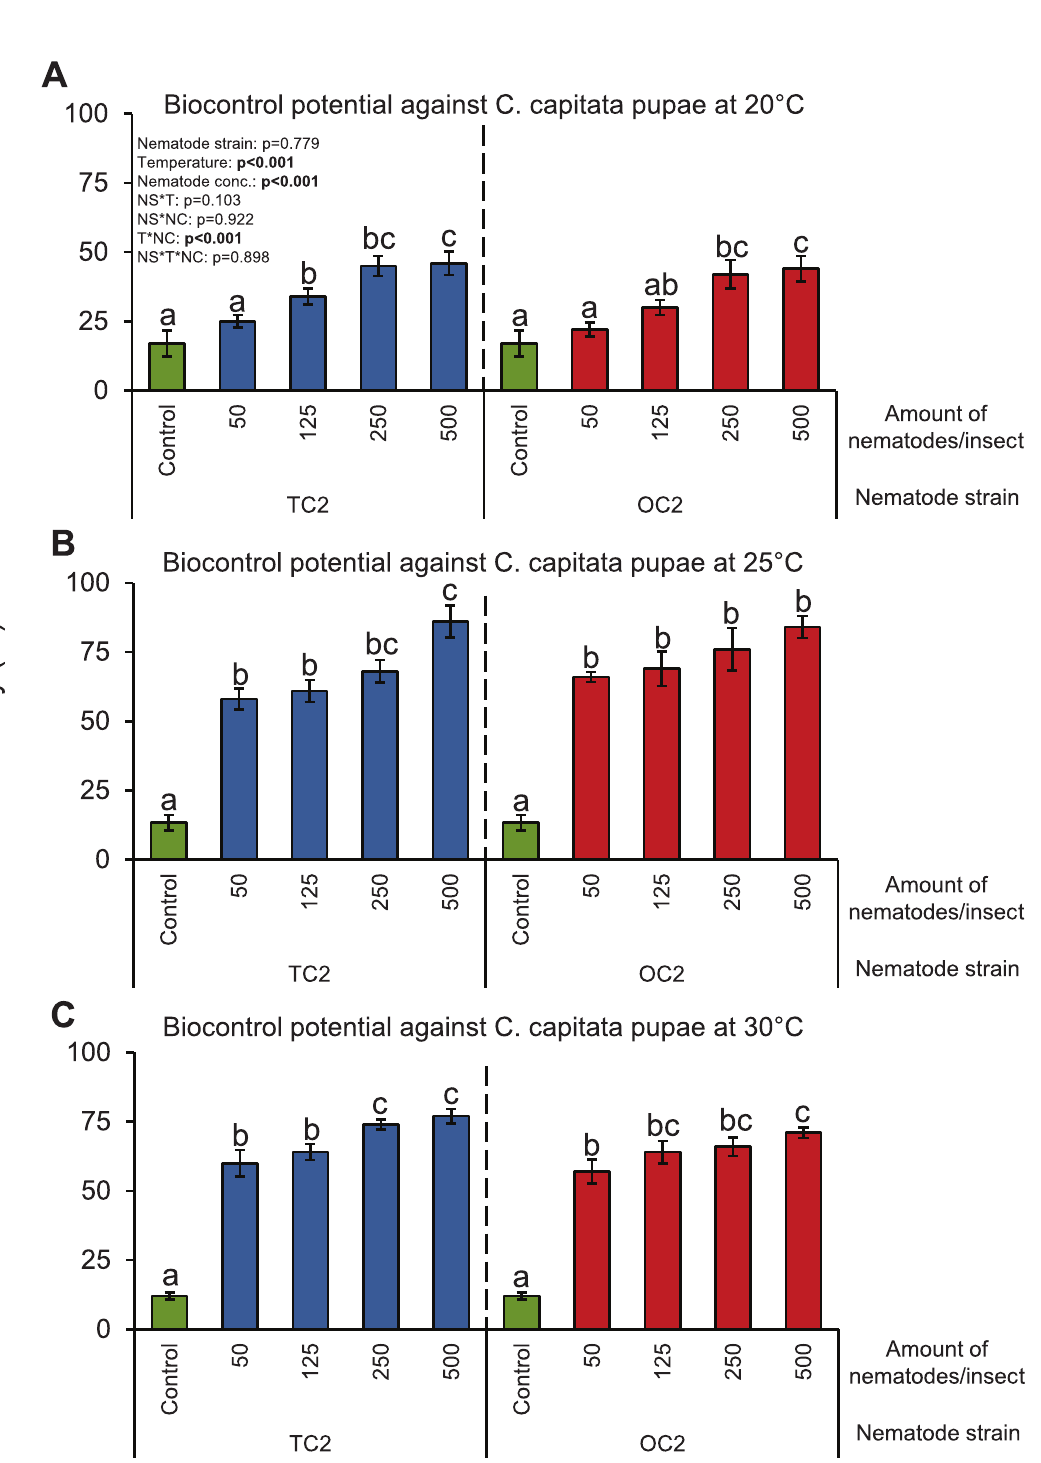
Fig 4. Biocontrol potential of O . tipulae nematodes against C . capitata pupae at different temperatures. Mean ( ± S.E.M.) mortality of C . capitata pupae after applying different O . tipulae nematodes at: (A) 20˚C, (B) 25˚C, and (C) 30˚C. Five Petri plates with 20 pupae each per nematode concentration were assayed (n = 5). Different letters indicate significant differences between treatments within each nematode strain and temperature combination (P < 0.05 by three-way ANOVA with Holm’s multiple comparisons test).